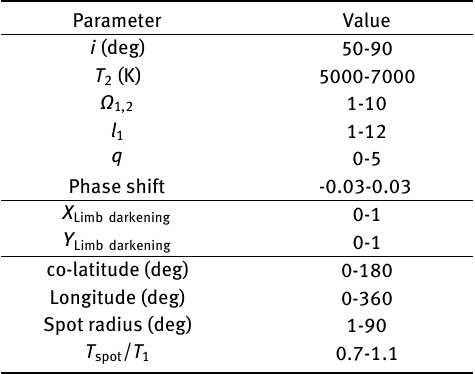
Table 3. Free parameters and search range in MC